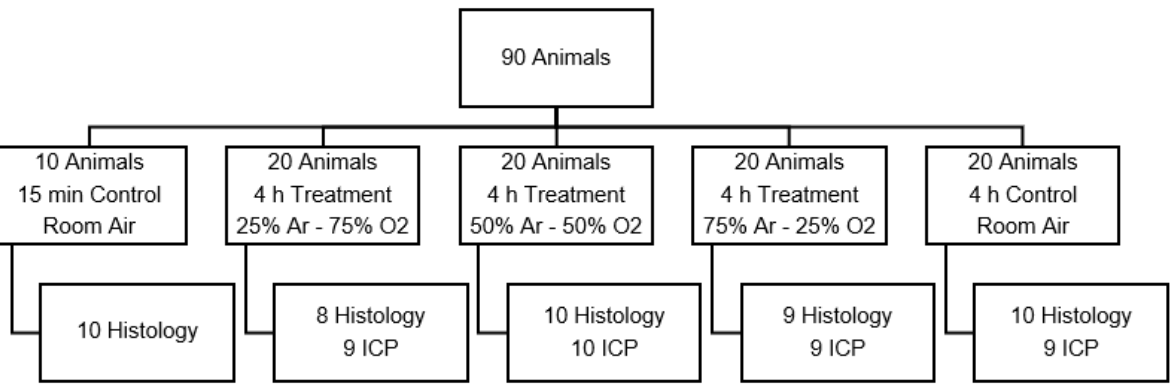
Figure 1. Animal distribution of test series A, which was designed to find the optimal argon con- centration. (Ar: argon; O2: oxygen; ICP: intracranial pressure measurement). concentration. (Ar: argon; O2: oxygen; ICP: intracranial pressure